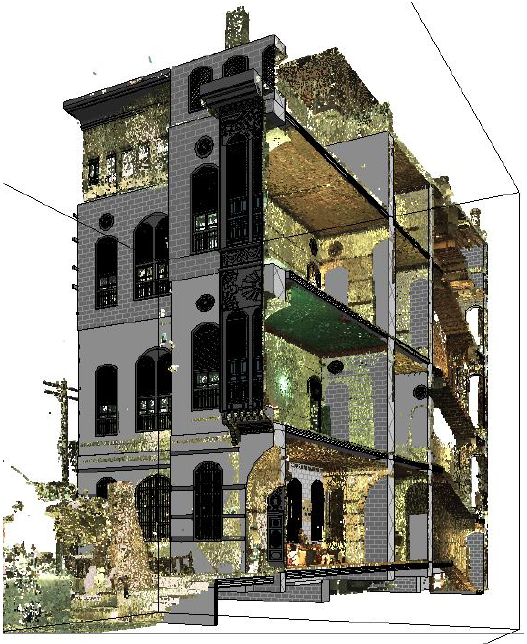
Figure 7: 3D section on the JHBIM model and the point